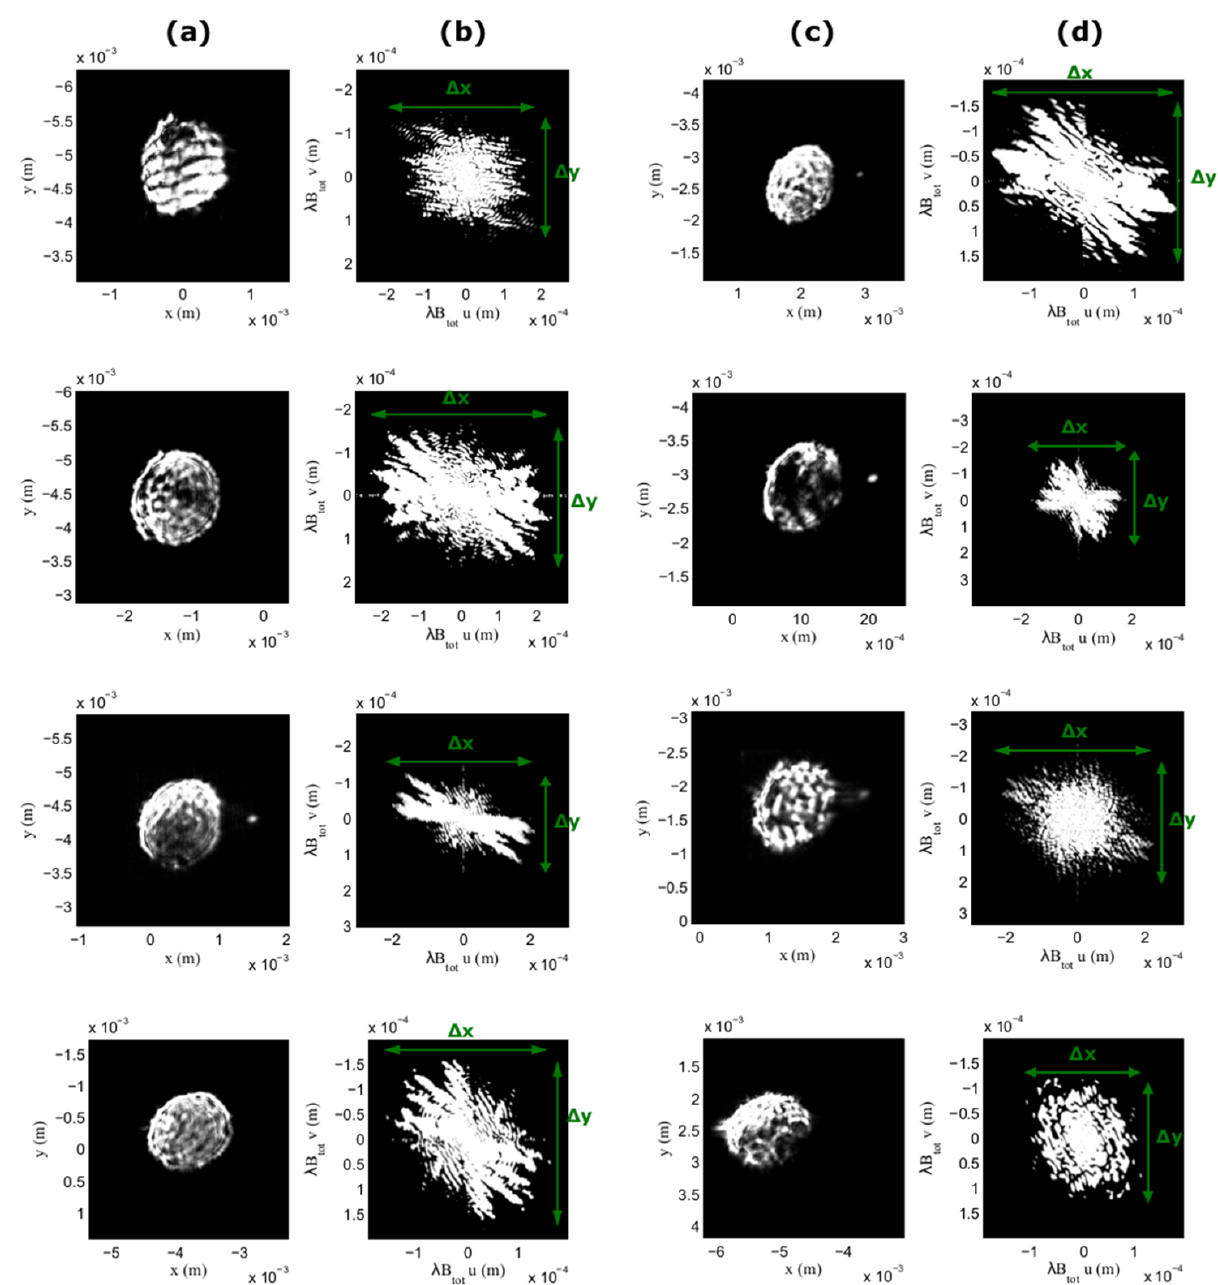
Figure 3. Typical IPI images of eight ice particles in columns ( a , c ), The corresponding 2-Dimensional Fourier transforms of the IPI images (presented in ( a , c )) in columns ( b , d ). The number of grey levels has been reduced in this figure to enhance the contrast but all analyses were made with the original images.